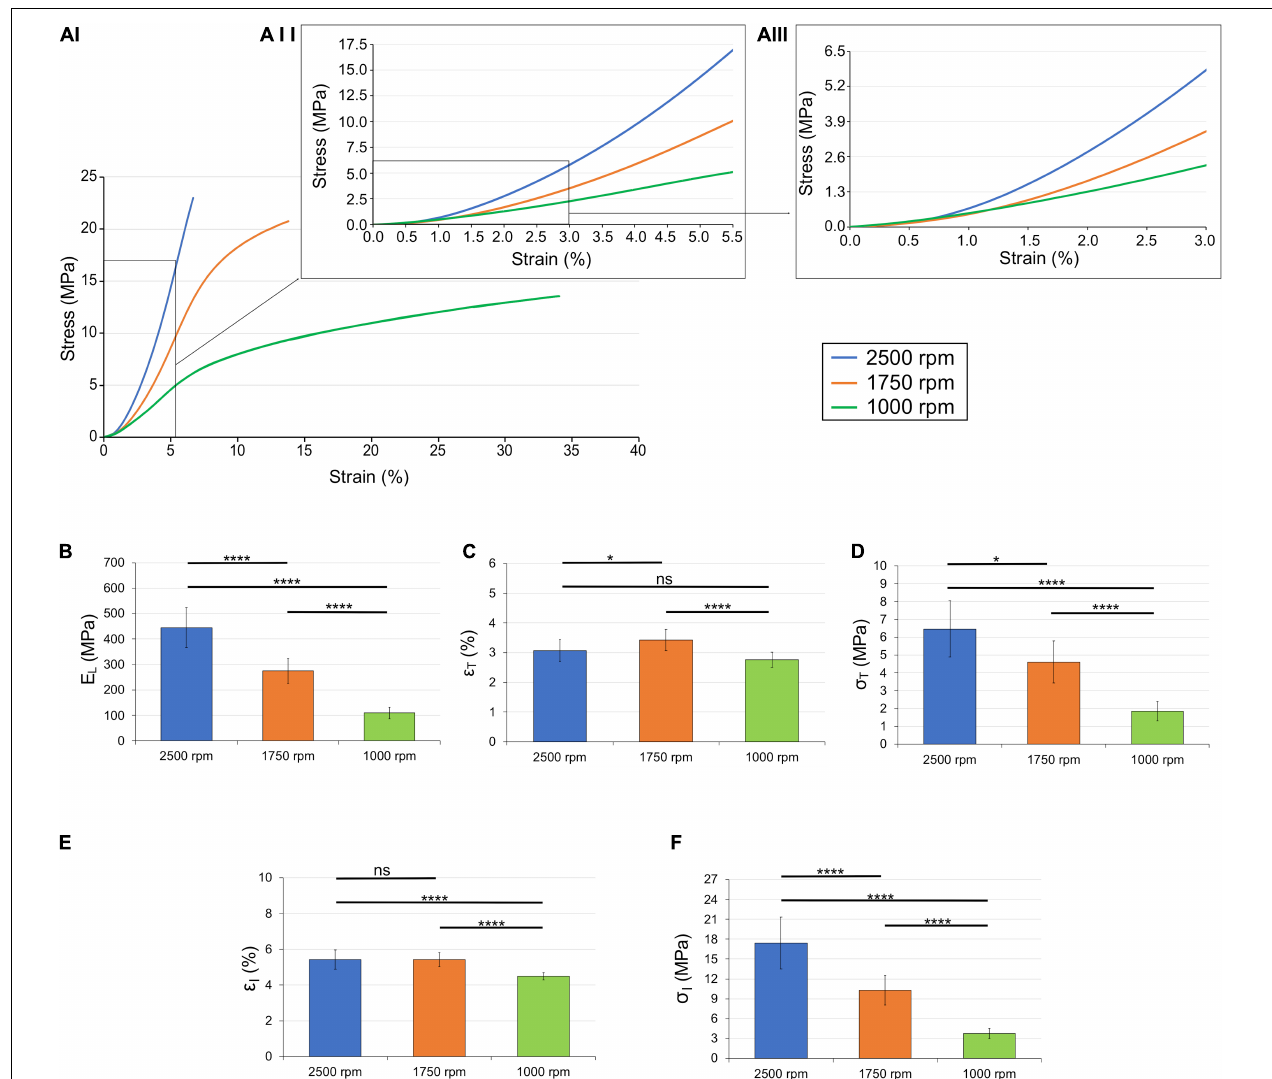
FIGURE 6 | Mechanical behavior of the different bundles categories: (AI) overlay of the typical stress-strain curves; (AII) zoom-in up to the inflection points; (AIII) zoom-in up to the transition points. Comparison between the mechanical properties of the bundles: (B) linear region modulus; (C) transition strain; (D) transition stress; (E) inflection strain; and (F) inflection stress. The mean and standard deviation are represented for each group. The statistical significance of differences is indicated (* p ≤ 0.05, ** p ≤ 0.01, *** p ≤ 0.001, **** p < 0.0001, and ns, not